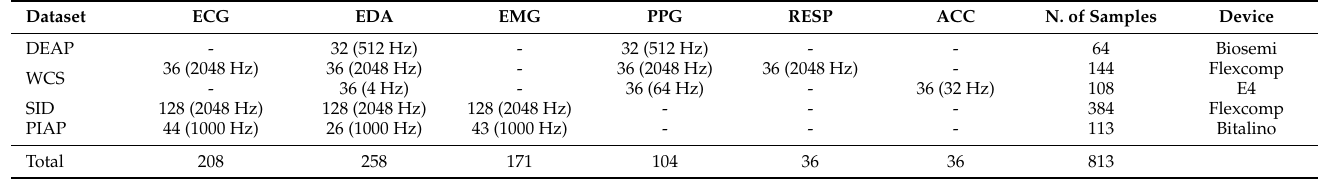
Table 1. Number of samples per type of signal and source dataset, with sampling frequency (in Hz) and devices.